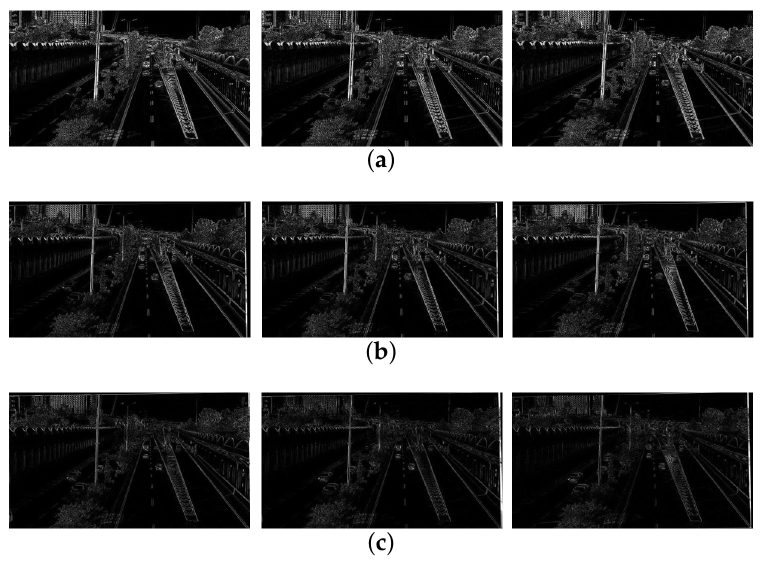
Figure 13. Experiment results: ( a ) differences of original video (129th, 130th, and 131st frames), ( b ) the stabilized video of [10] (129th, 130th, and 131st frames), ( c ) our stabilized video (129th, 130th, and 131st